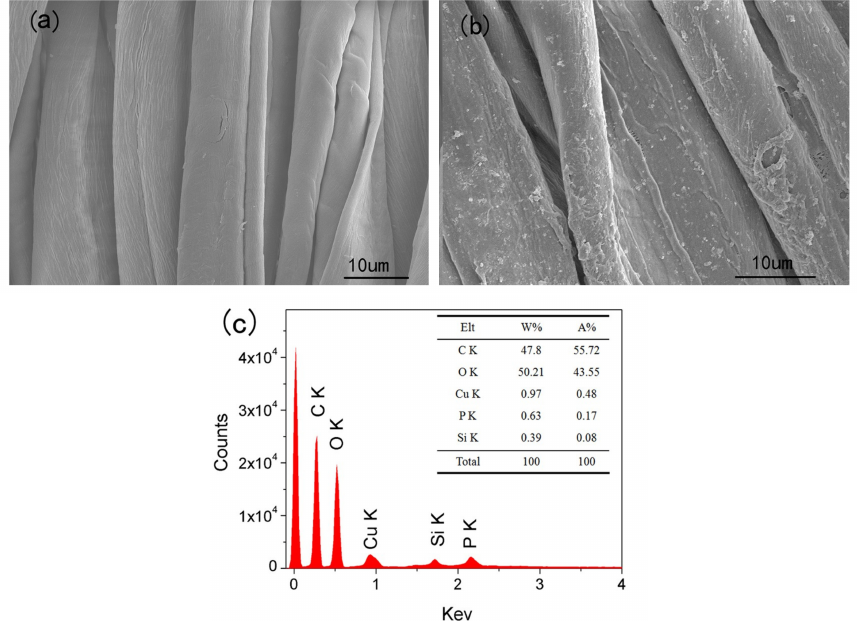
Figure 4. Scanning electron microscopy images of ( a ) cotton fabrics, ( b ) CHP-IP6 coated cotton fabrics, and ( c ) EDS of CHP-IP6-coated cotton